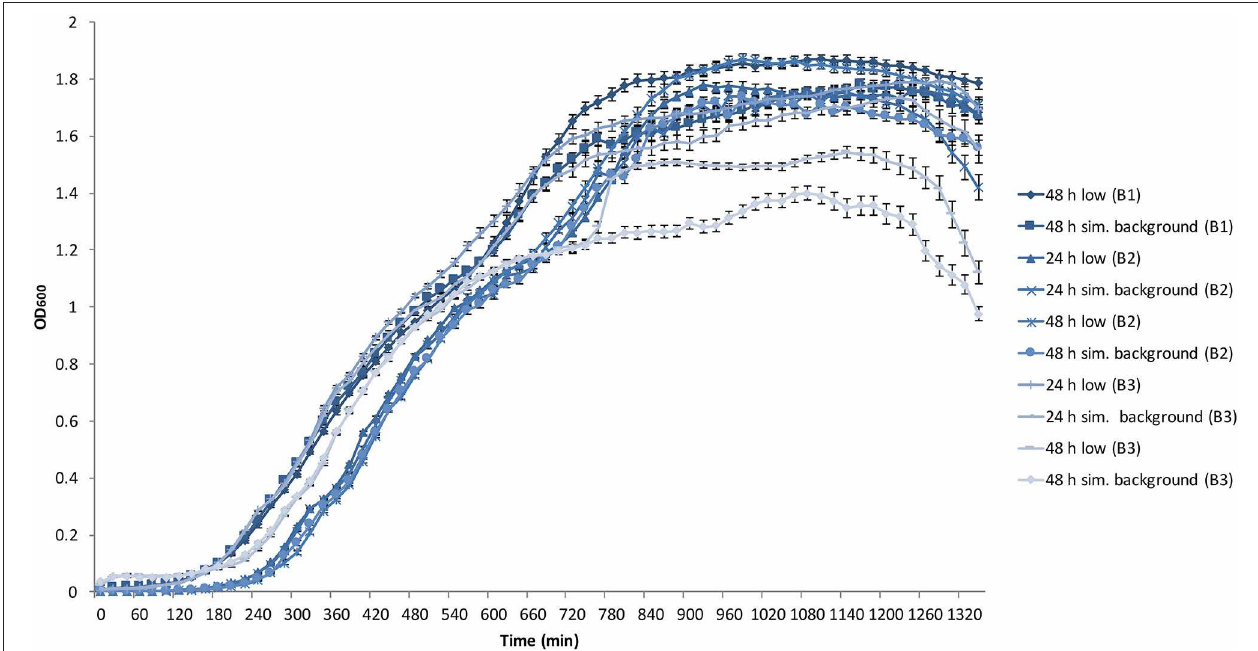
FIGURE 3 | Average ( n = 84) of B. subtilis growth curves at the determined low radiation (low) and artificial background radiation (“sim. background”) dose rate: 24 and 48h denote time in hours that bacteria batch has spent in respective conditions; B1-3 = experiment run number. Error bars show ± standard error ( n =